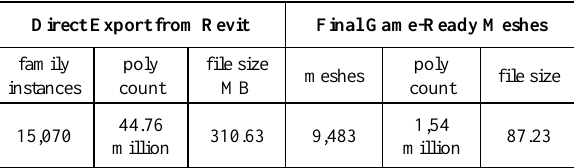
Figure 11. Polycount for the Library of Parliament comparing polycount from direct export from Revit against the